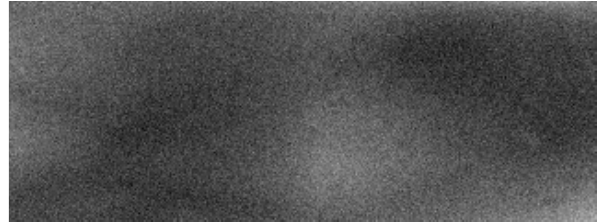
Figure 8. Example of ROI image after setting (0.05) the Gaussian noise